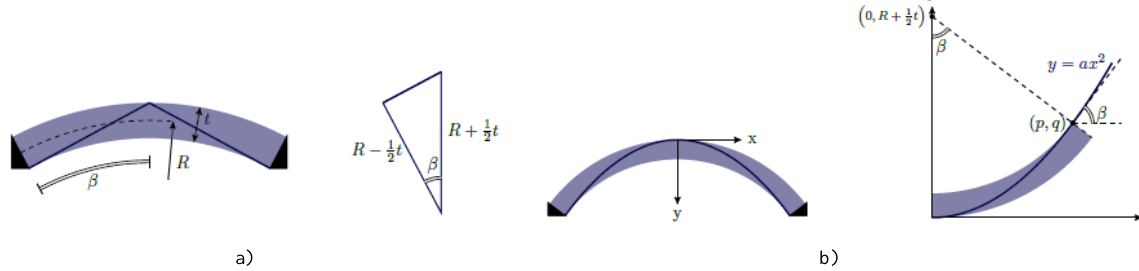
Fig. 3 Geometry definitions for analytical derivation; a) boundary between region A and B; b) boundary between region B and